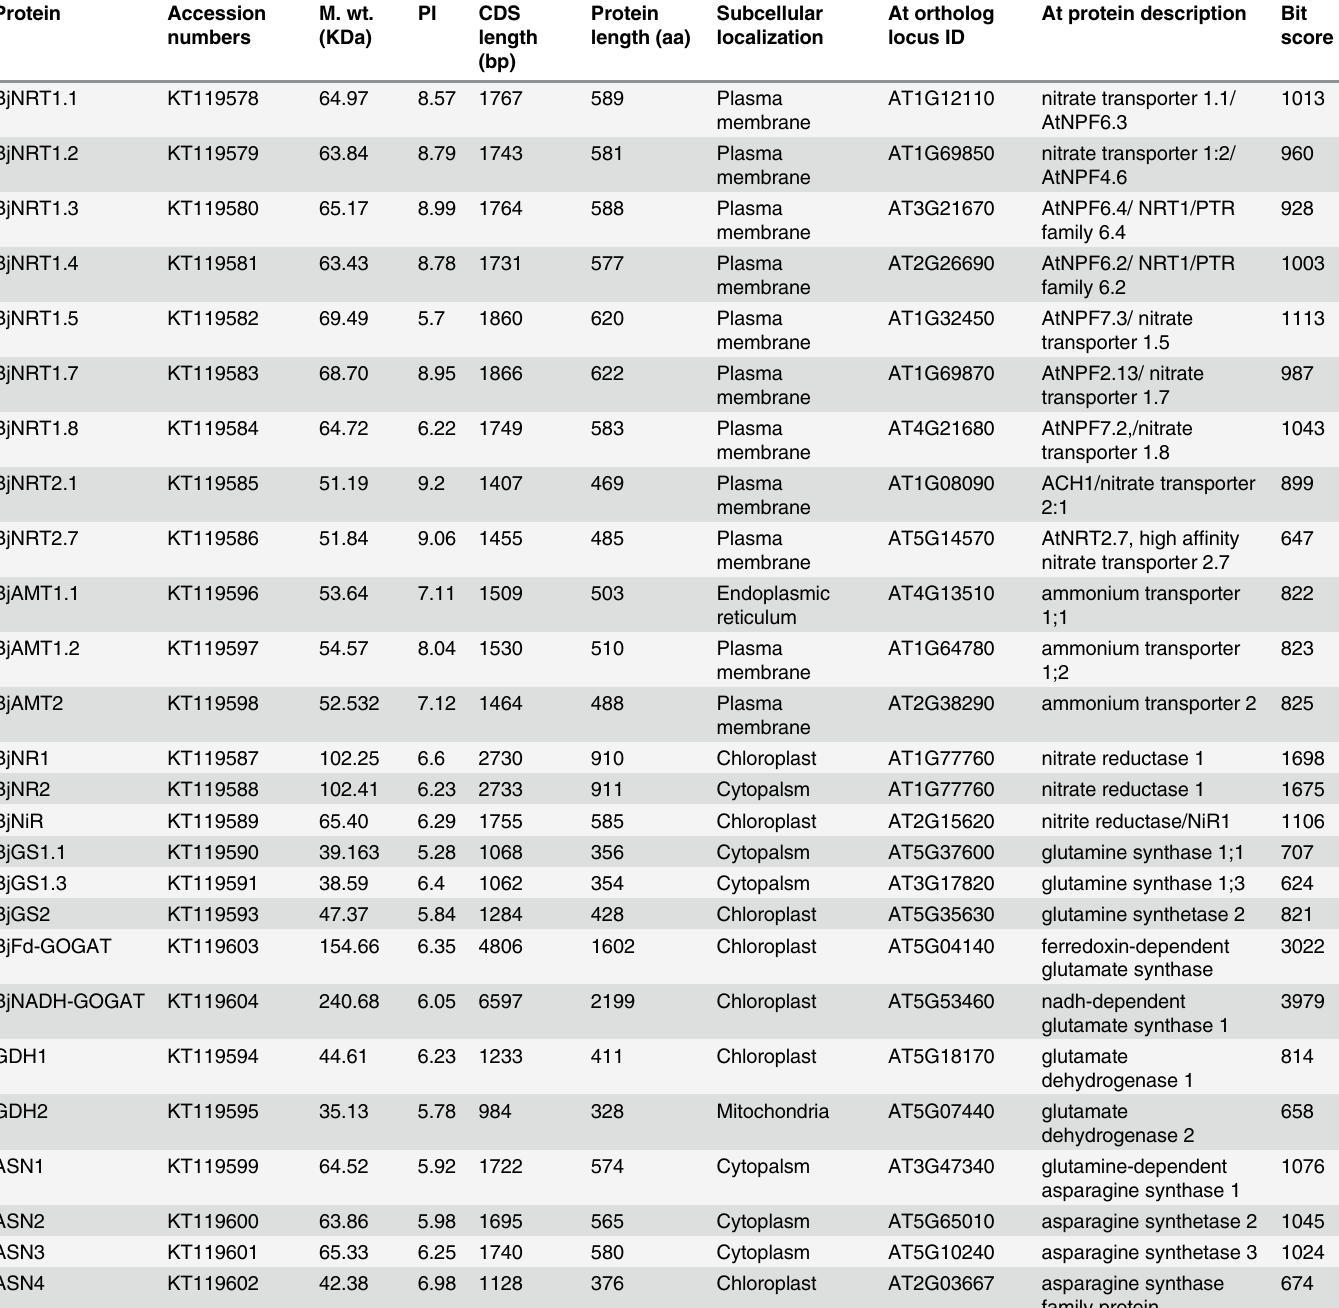
Table 1. List of proteins along with their molecular weight (M. wt.), isoelectric point (PI), CDS and protein length, subcellular localization and Arabi- dopsis thaliana orthologs.